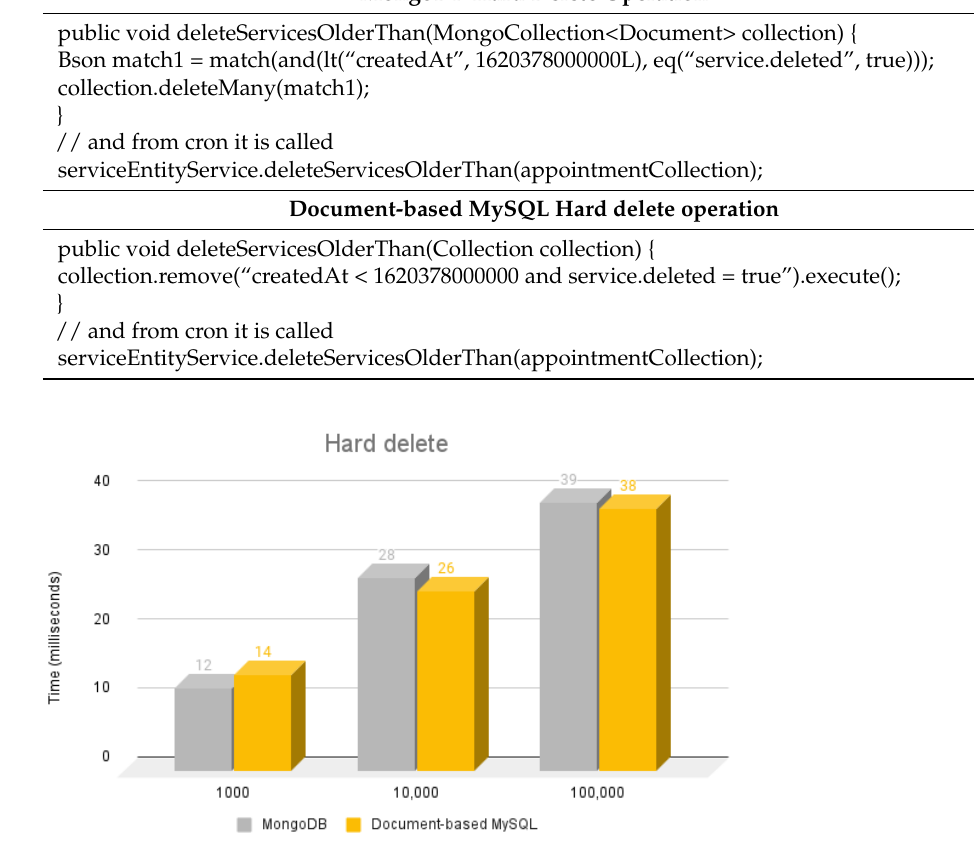
Figure 10. Execution times for hard delete operation.